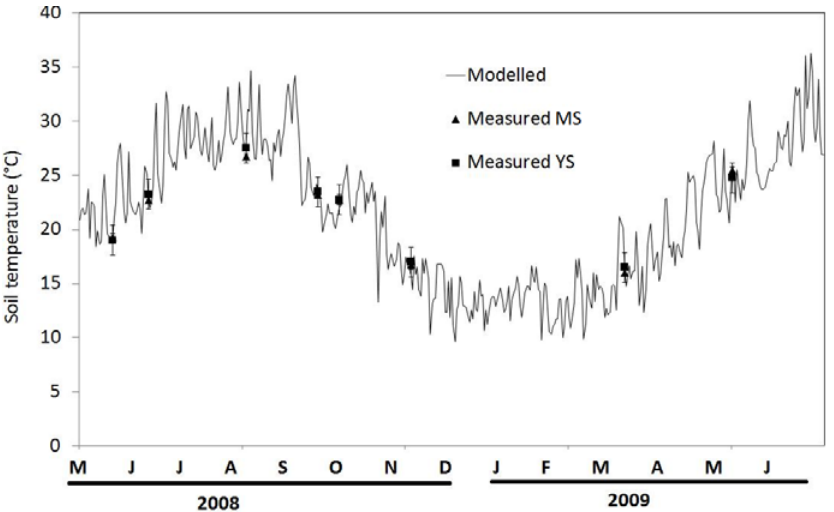
Figure 5. Seasonal variations of modelled (solid line) and observed (YS: filled square, MS: filled triangle) soil temperature of the top soil layer (0–30 cm). Error bars are standard errors of the